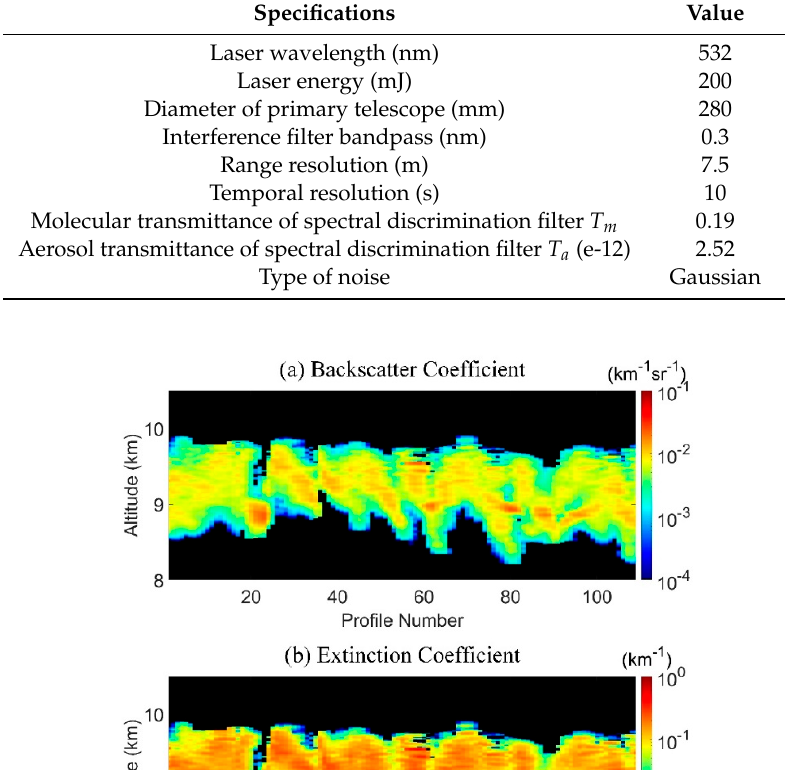
Table 1. System specifications employed by Monte-Carlo (MC) simulations.